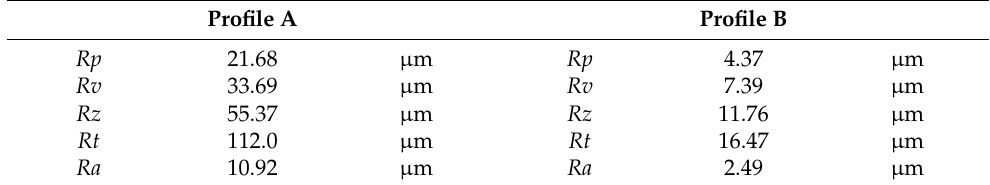
Figure 5. Examples of surface topography—test 5, ( a ) top view, ( b ) angled view, ( c ) profile A, ( d ) profile B, ( e ) collection of profiles. Table 2. Measurement results of the roughness parameters (ISO4287) profiles A and B in Figure 5. Profile A Profile